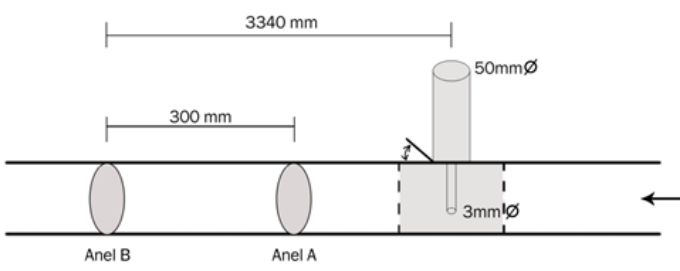
Figure 10. Schematic of the relative position of the EIT electrodes sections and NaCl injection inlet. Table 2. Table of fibre concentrations and flow velocities used for the velocity estimation tests. Concentration (wt / wt)